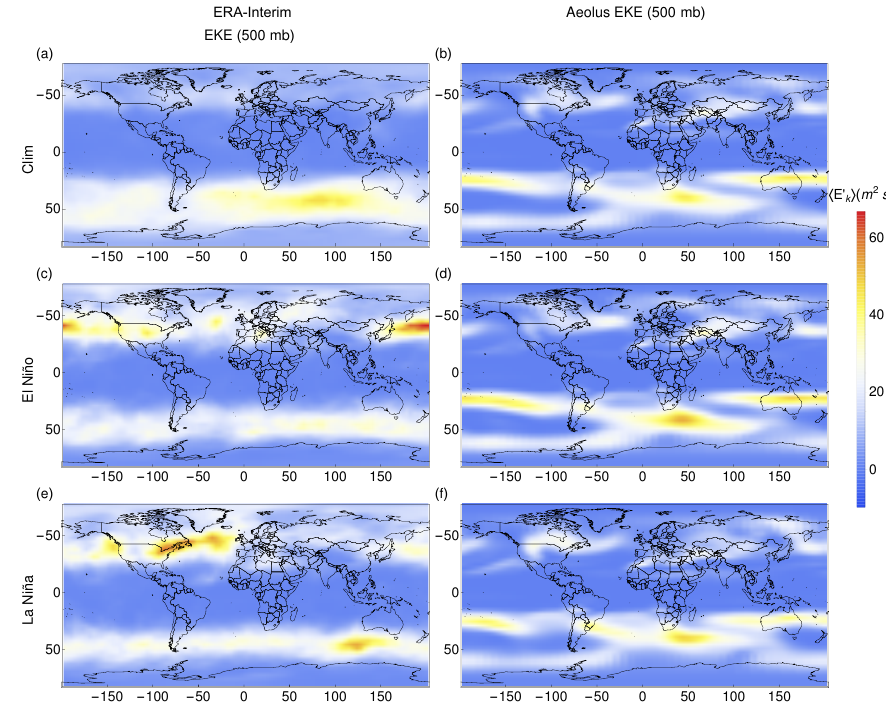
(cid:105) in August at 500mb (compare Fig. k